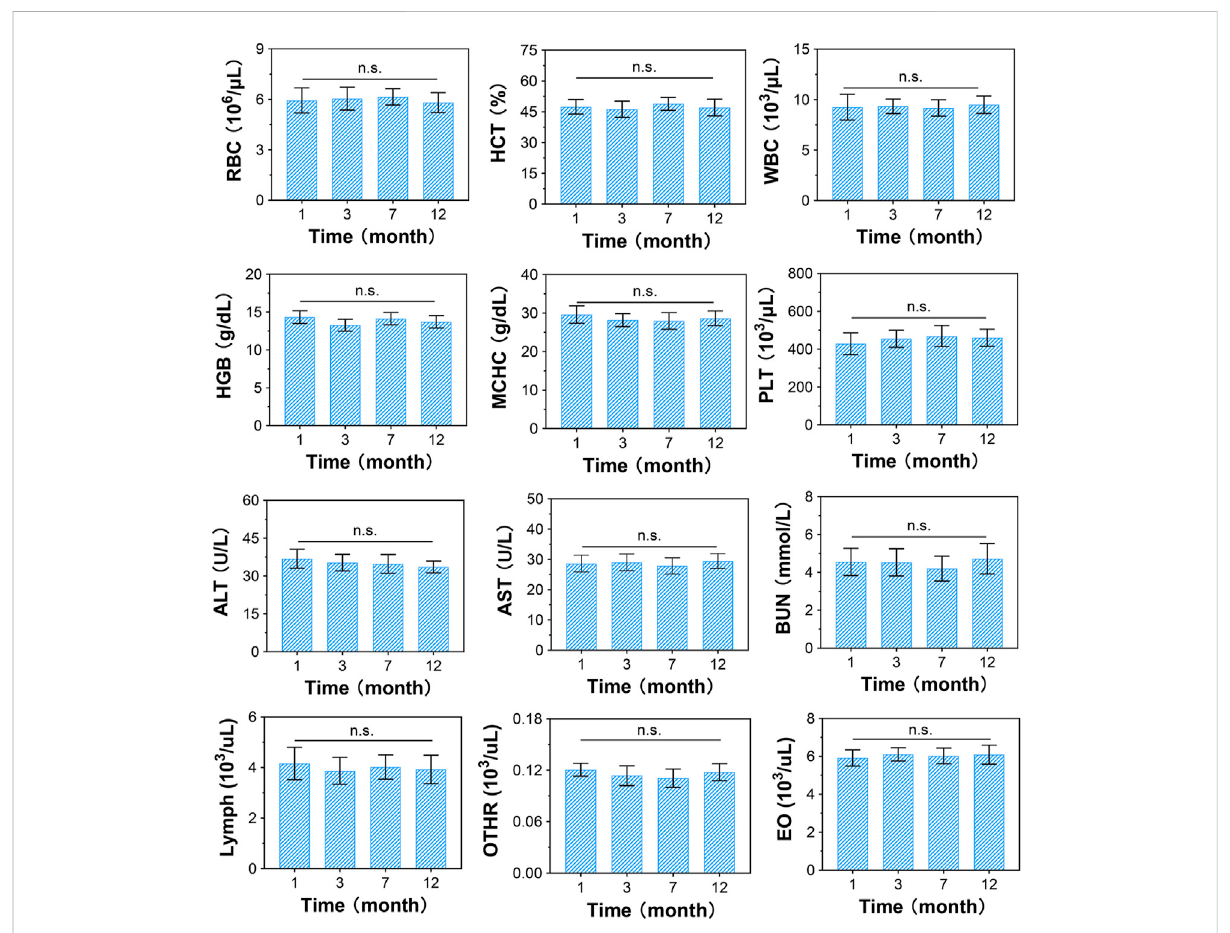
FIGURE 4 Blood biochemical evaluation of CSDP implanted in non-human primatemodel.The blood routineincludes red blood cells (RBCs), hematocrit (HCT), white blood cells (WBCs), hemoglobin (HGB), mean corpuscular hemoglobin concentration (MCHC), platelets (PLTs), lymphocytes (lymphs), neutrophils (OTHRs), and eosinophils (EOs). Blood levels of alanine aminotransferase (ALT) and aspartate aminotransferase (AST) used as liver function markers. Blood urea nitrogen (BUN) used as kidney function marker. n.s., no statistical difference ( n =